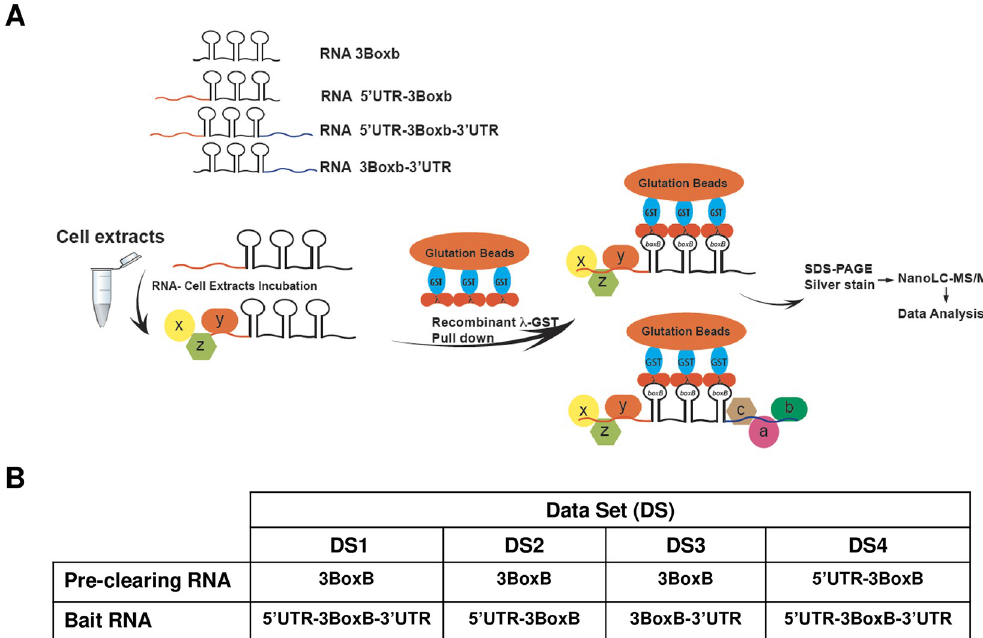
Fig 5. Identifications of host proteins that interact with the UTRs of the ANDV SmRNA. (A) Depiction of the GRNA affinity chromatography combined with nanoscale liquid chromatography coupled to tandem mass spectrometry (nano LC-MS/MS) strategy used to identify host proteins that interact with the 3’UTR of the ANDV SmRNA. (B) HeLa extracts precleared with 3BoxB, or 5’UTR-3BoxB RNA were incubated with different in vitro transcribed bait RNA. The RNA- proteins complexes were pulled down using recombinant λ -GST protein as described in [42]. The proteins bound to 3BoxB- 3’UTR, 5’UTR-3BoxB, 5’UTR-3BoxB-3’UTR RNAs identified by Nano LC-MS/MS (Applied Biomics, Inc., Hayward, CA, USA) were grouped into four datasets (DS, the list of proteins can be found in S1 Data). not in DS2 (Fig 5B). The initial analysis considered only DS3 and DS4 and their shared proteins (S1 Data, DS3-DS4). From the list of DS3 and DS4 shared proteins, the Neuronal acetylcholine receptor subunit alpha-10 (Accession number ACH10_HUMAN) and the Zinc finger protein 169 (Accession number ZN169_HUMAN) were also present in DS2 but not in DS1 (S1 Data). Therefore, these proteins were not considered for further analysis. Most of the other proteins shared in DS3 and DS4 such as Ras GTPase-activating-like protein IQGAP1 (Accession number IQGA1_HUMAN), Uncharacterized protein C2orf77 (Accession number CB077_HUMAN), Neuroblastoma-amplified sequence (Accession number NBAS_HUMAN), and others were present in all DS (1 through 4; see S1 Data). These proteins were also discarded for further anal- ysis. The DDB1-CUL4-associated factor 5 (Accession number DCAF5_HUMAN), member of the cullin-RING ubiquitin ligases (CRLs) family of ubiquitin E3 ligases [43], and the human RNA chaperone protein Mex3A (hMex3A), an RBP that contains two K homology (KH) domains and a C-terminal RING finger module [44], were the only proteins to fulfill all selec- tion criteria (S1 Data; present in DS3, DS4, and DS1, but not in DS2). The DNA excision repair protein ERCC-6-like (Accession number ERC6L_HUMAN), protein SIX6OS1 (Accession number S6OS1_HUMAN), and the E3 ubiquitin-protein ligase UBR3 (Accession number UBR3_HUMAN) that were present in DS3 and DS4 but not DS1 (S1 Data), were also good can- didate 3’UTR-binding proteins, however, were arbitrarily omitted from the study.